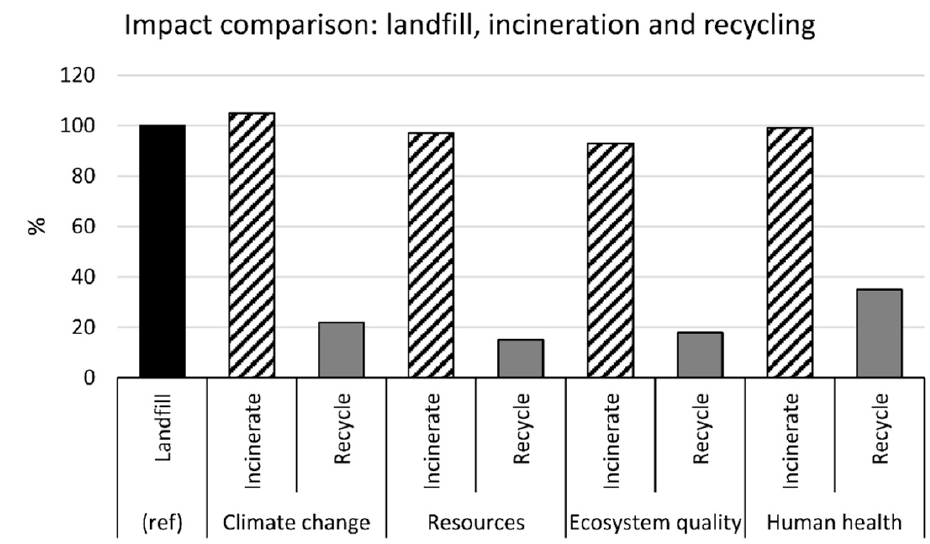
Figure 1. The impact comparison of landfill disposal, incineration, and recycling [24]. Additional EoL solutions for composites include mechanical recycling, pyrolysis, fluidised-bed treatments, chemical solvent processes, and supercritical water methods